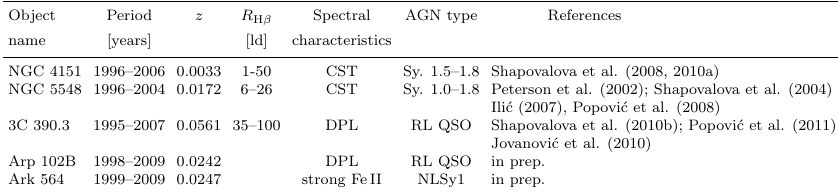
Table 1. Basic data for the selected objects: object name, monitoring period, redshift, radius of the BLR determined from the H (cid:12) line, spectral characteristics (DPL stands for double-peaked line, CST for changing spectral type), AGN type and